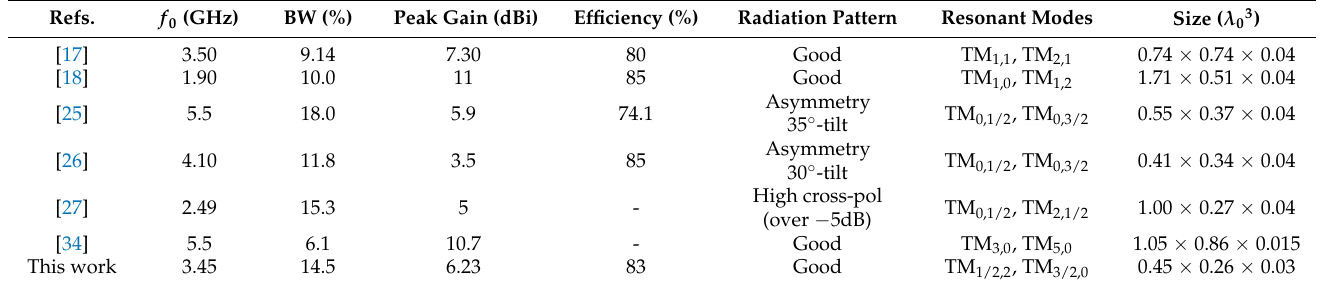
Table 3. Performance comparison with the previous